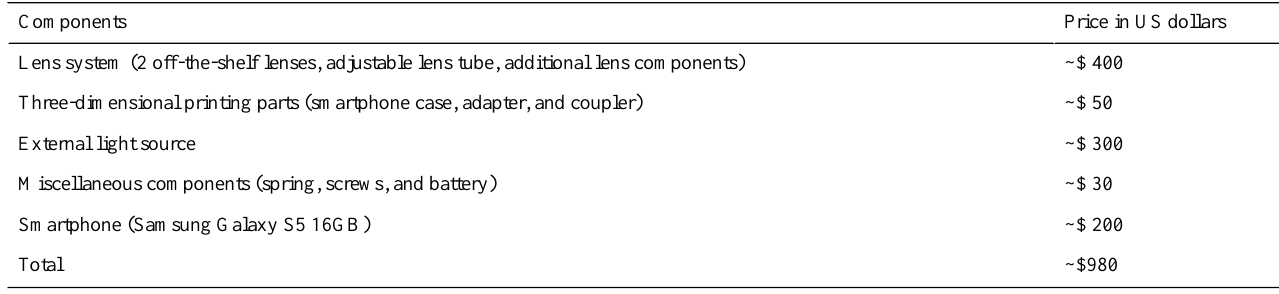
Table 1. Cost of smartphone-based endoscope system.